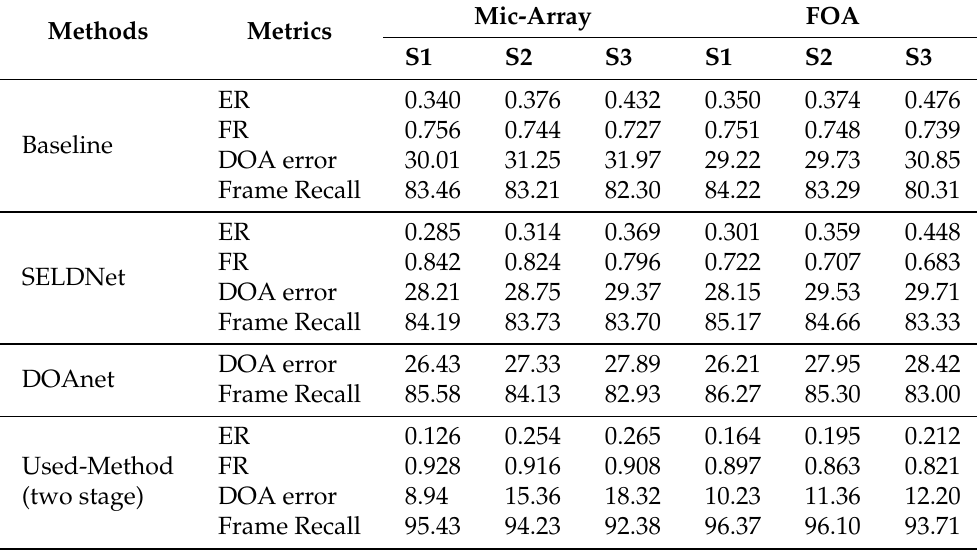
Table 2. Performance comparison between other similar methods and the proposed method in scenario-1 escalator descending direction.